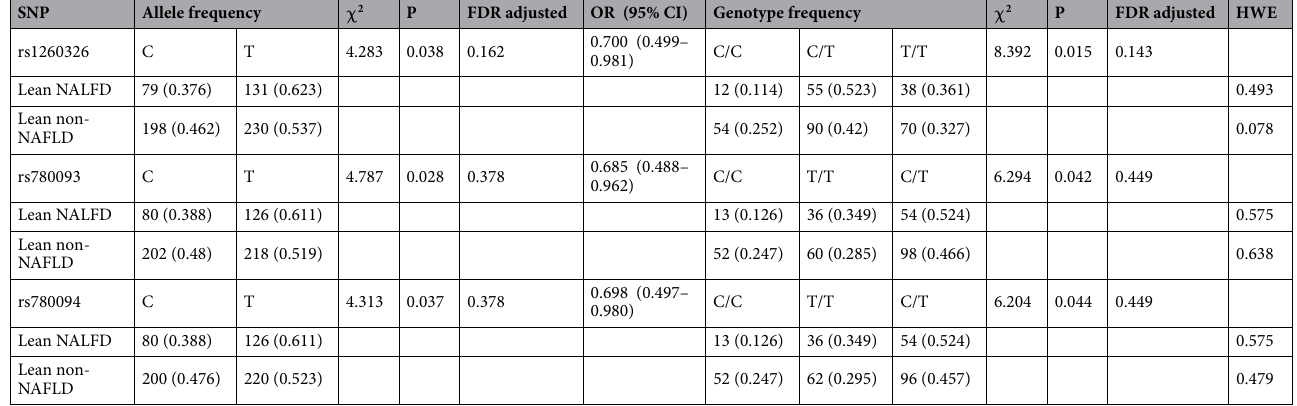
Table 3. GCKR allele and genotype distribution in lean individuals. FDR false discovery rate, GCKR glucokinase regulator, HWE Hardy–Weinberg equilibrium, OR odds ratio, SNP single nucleotide